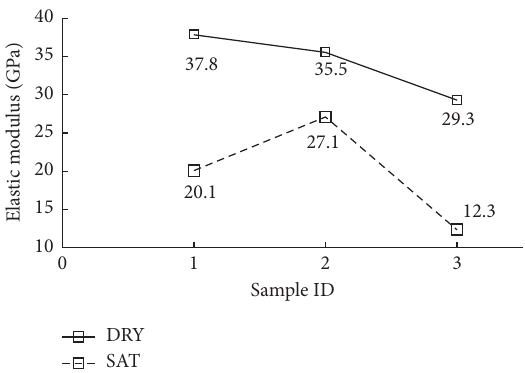
Figure 13: Elastic modulus of tuff in the tunnel of Mila Mountain under dry and saturated